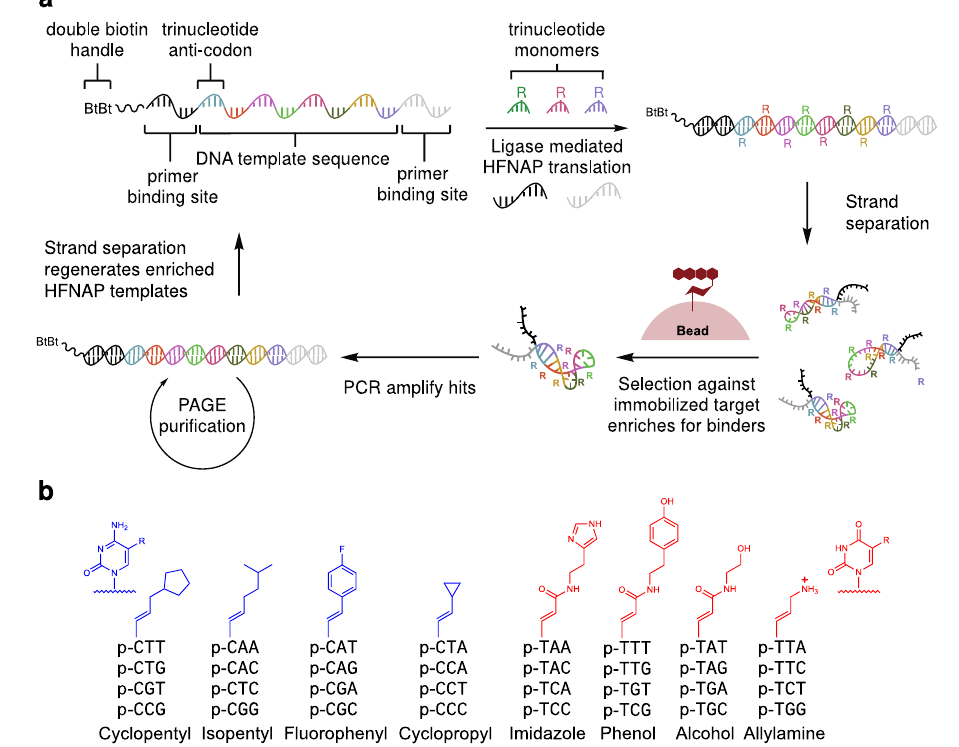
Fig. 1 | HFNAP building blocks, translation, and selection. a Overview of the HFNAP translation, selection against daunomycin, and reverse translation to regenerate DNA templates. b Structures of the 5'-phosphorylated trinucleotide